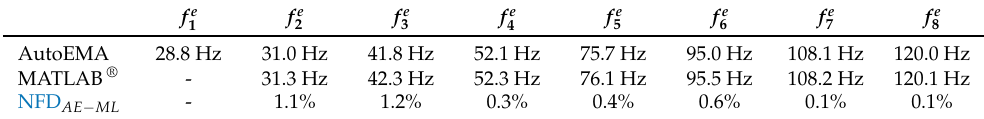
found by MATLAB ® and AutoEMA for WPT position Table 8. Comparison of eigenfrequencies f e i z 2 ; "-" indicates that no matching mode with a MAC value of at least 80% was found.